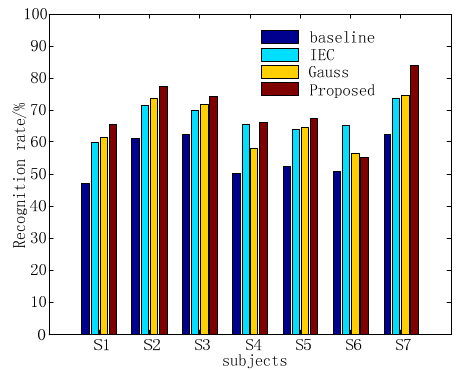
Figure 9. Recognition rate for environmental sound. Table 3. Statistical analysis of the recognition rate for environmental